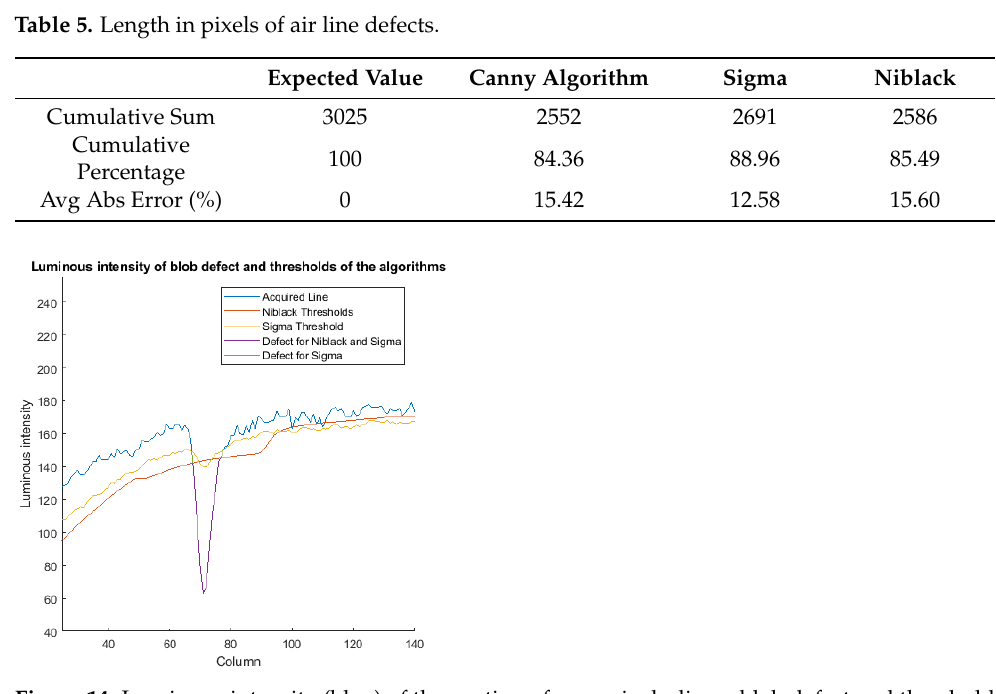
Figure 14. Luminous intensity (blue) of the portion of a row, including a blob defect and threshold used with Sigma (yellow) and Niblack (red). In correspondence of the blob columns, Niblack thresh- olds are lower than Sigma, and the resulting detected region (purple) is smaller than Sigma (green).